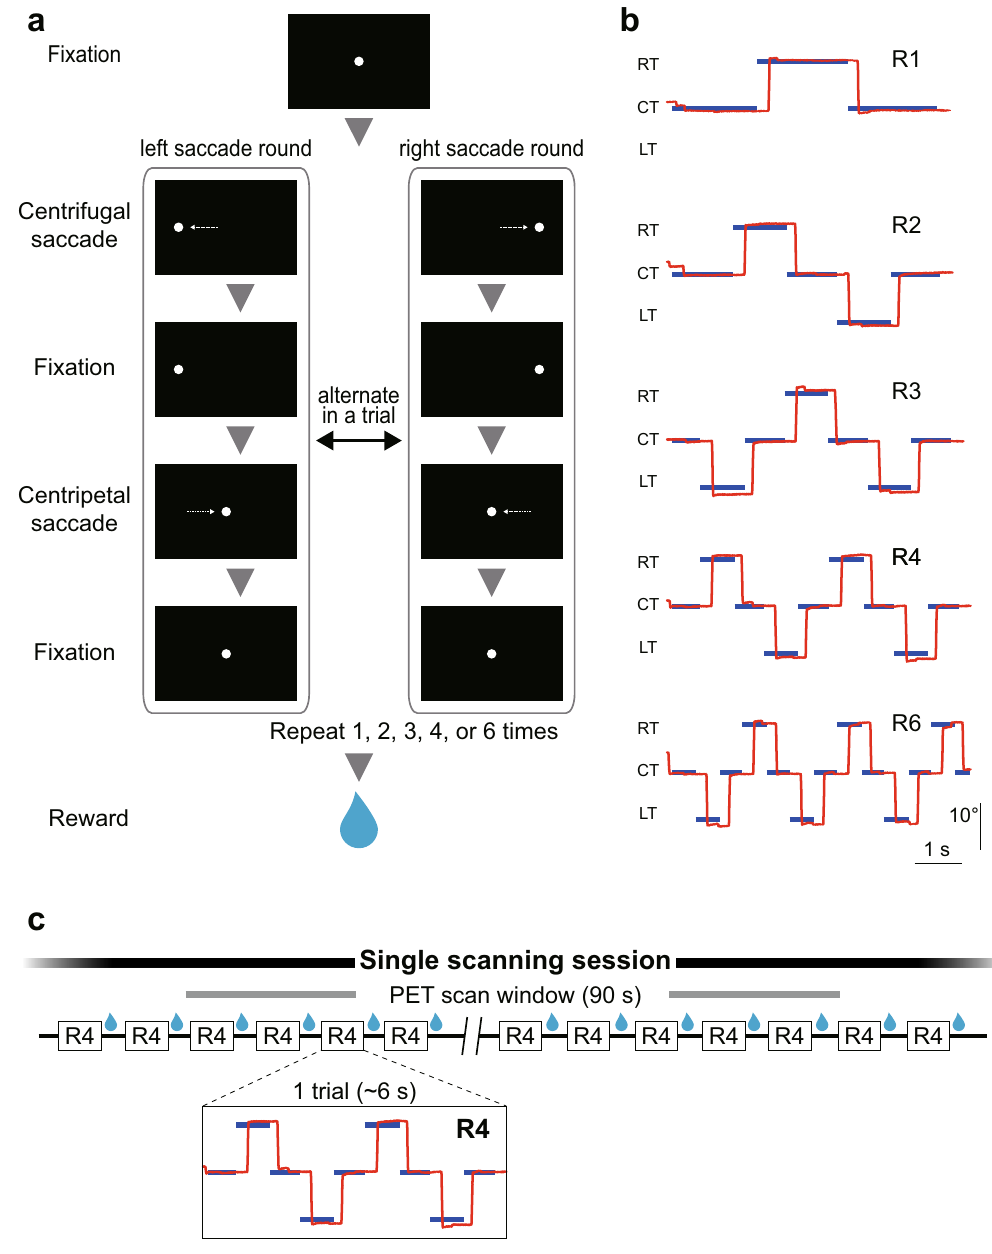
Fig. 2 Task design: round saccade task. a The round saccade task used in the PET imaging studies. A trial included 1, 2, 3, 4, or 6 rounds of saccades, determined in each task condition. b Example of trials in each condition. Vertical axis represents horizontal location on the monitor. Red lines indicate eye position, and blue lines indicate the locations of the target. Note that it took ~6 s to perform a single trial in all fi ve task conditions. c A schematic drawing of a scanning session sequence. Each box indicates a single trial. Black lines indicate the intertrial intervals. A single scanning session (2 min) included ~20 trials regardless of task condition. CT central target, LT left target, RT right